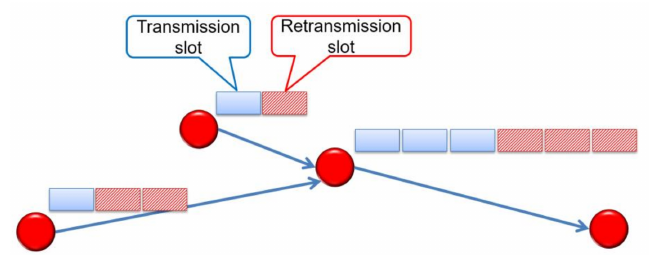
Figure 5. Conceptual diagram of the retransmission slots for data frames.